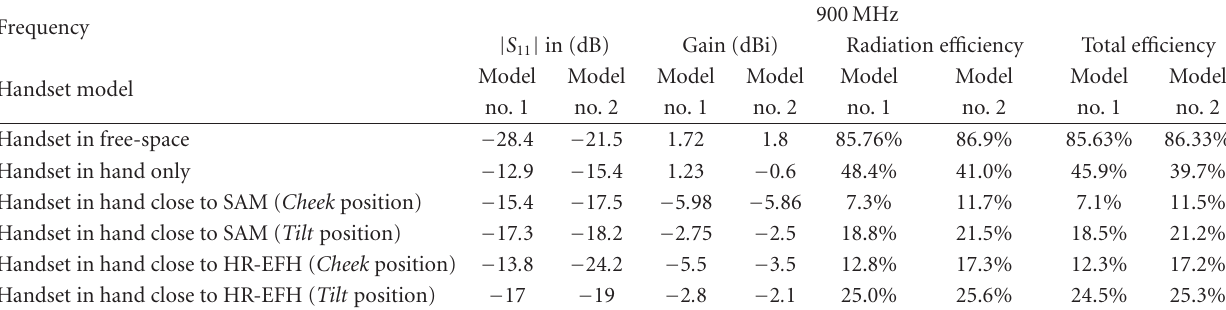
Table 3: Computational results of the antenna performance parameters of both handset models at 900 MHz in all cases.